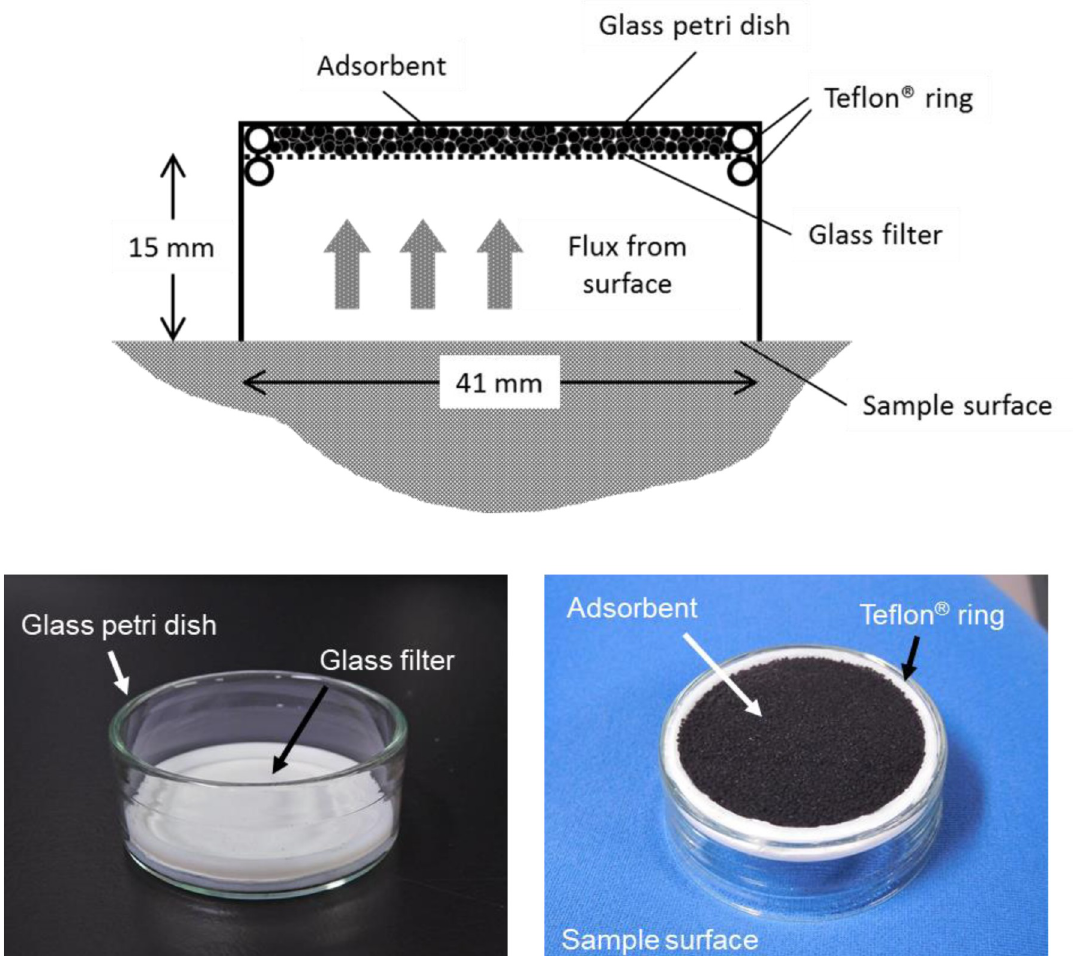
Fig 1. Schematic diagram and photographs of the passive flux